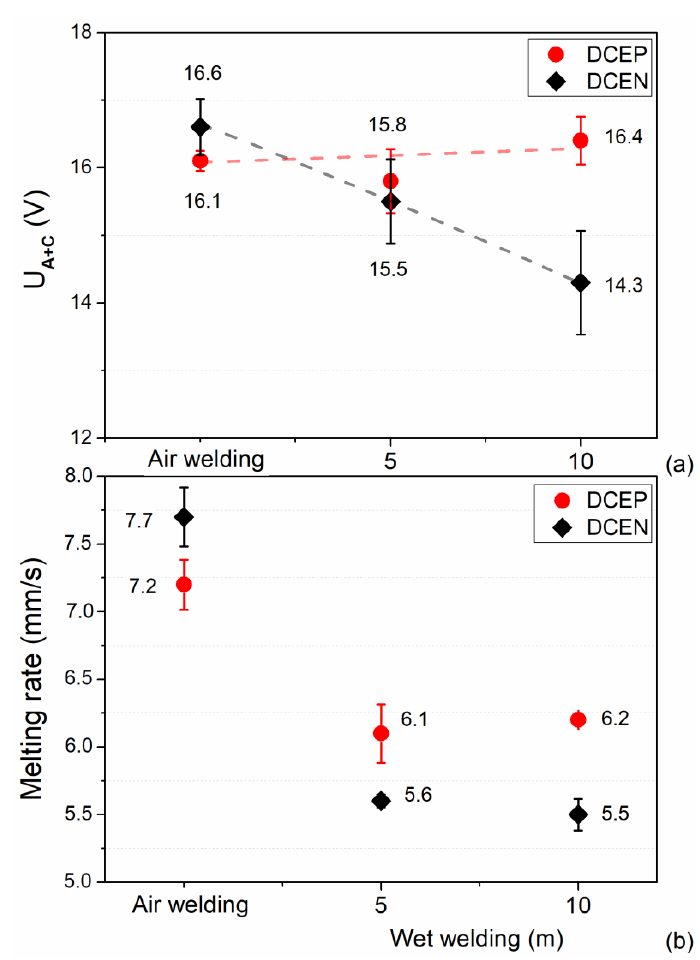
Figure 9. ( a ) Effect of polarity and hydrostatic pressure on the voltage drop in the anodic and cathodic connection (Ua+c). ( b ) Average melting rate for rutile electrode in both polarities and all conditions. Error bars show the standard deviation.